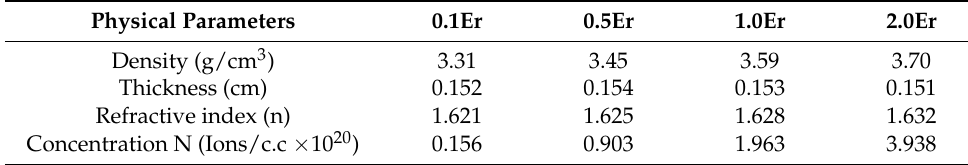
Table 1. The physical parameters of Er 3+ singly loaded studied glasses.